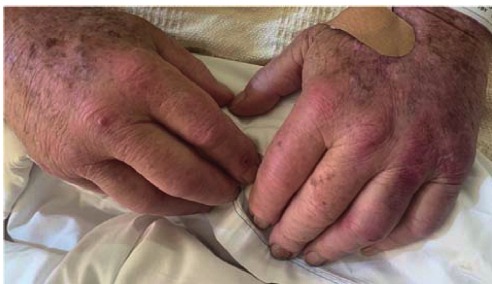
Figure 1: The patient had been prescribed oral mesalamine 2.4g twice a day in the past as a treatment for his ulcerative colitis, but the patient admitted to noncompliance due to inability to care for himself.